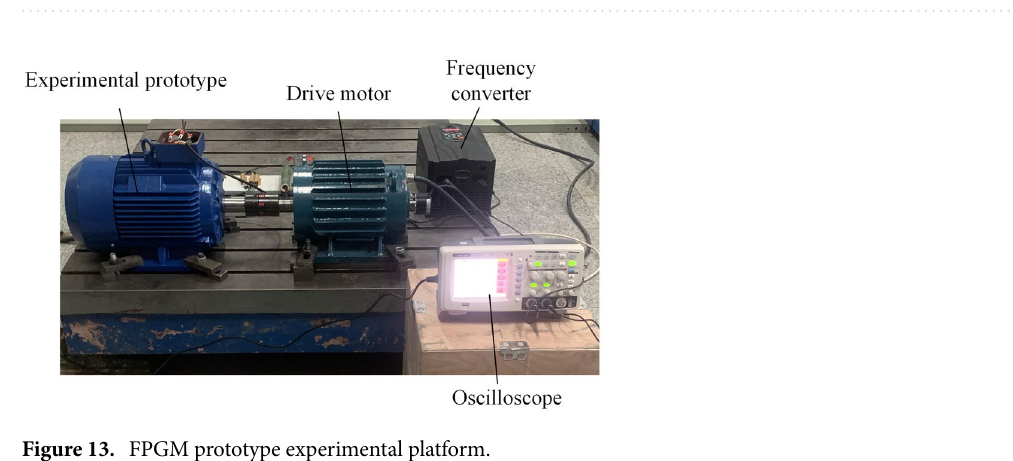
Figure 12. Photos of the FPGM prototype machine. ( a ) Stator steel lamination sheet, ( b ) rotor, ( c ) stator.